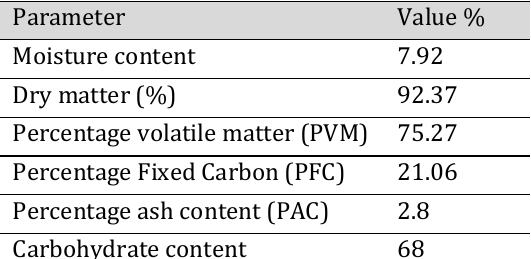
Table 1. The analysis results of white sorghum powder composed of 1:1:0.5 stalk: leaves: